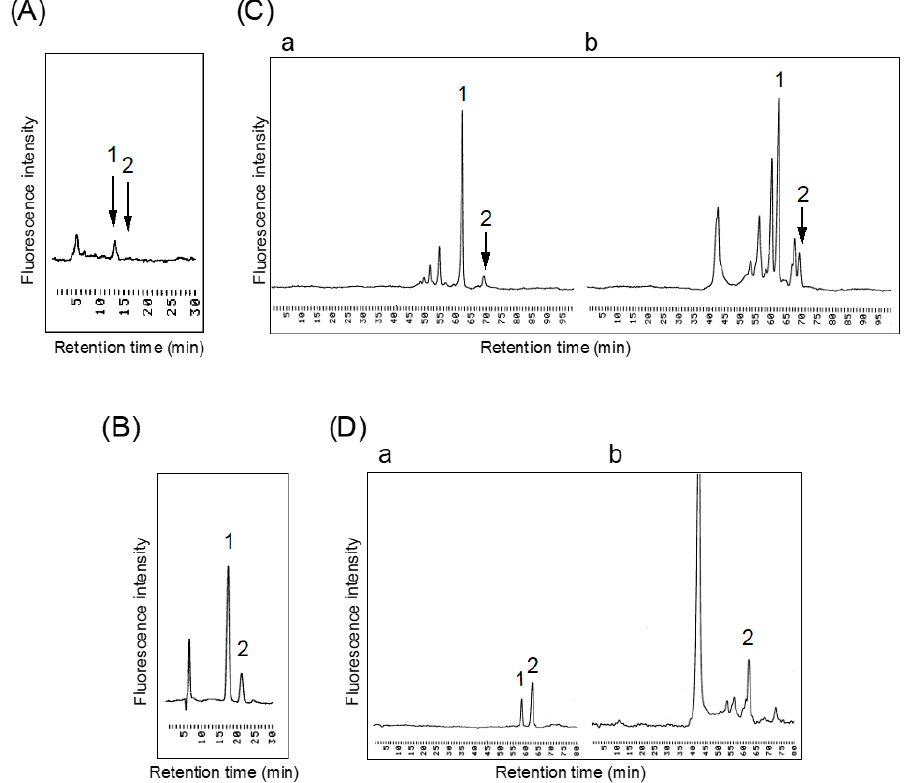
Figure 5. Chemical analysis of R-10G-binding protein. ( A ) HPLC analysis of sialic acid in purified R-10G-binding protein. Peak 1, NeuAc; peak 2, NeuGc. ( B ) HPLC analysis of amino sugars in R-10G-binding protein. Peak 1, GlcN; peak 2, GalN. ( C ) HPLC analysis of oligosaccharides released by endo- β -galactosidase digestion. Peak 1, GlcNAc(6S) β 1-3Gal; peak 2, GlcNAc β 1-3Gal. (a) Bovine cornea keratan sulfate, (b) R-10G-binding protein. ( D ) HPLC analysis of oligosaccharides released by keratanase II digestion. Peak 1, Gal(6S) β 1-4GlcNAc(6S); peak 2, Gal β 1-4GlcNAc(6S). (a) Bovine cornea keratan sulfate, (b) R-10G-binding